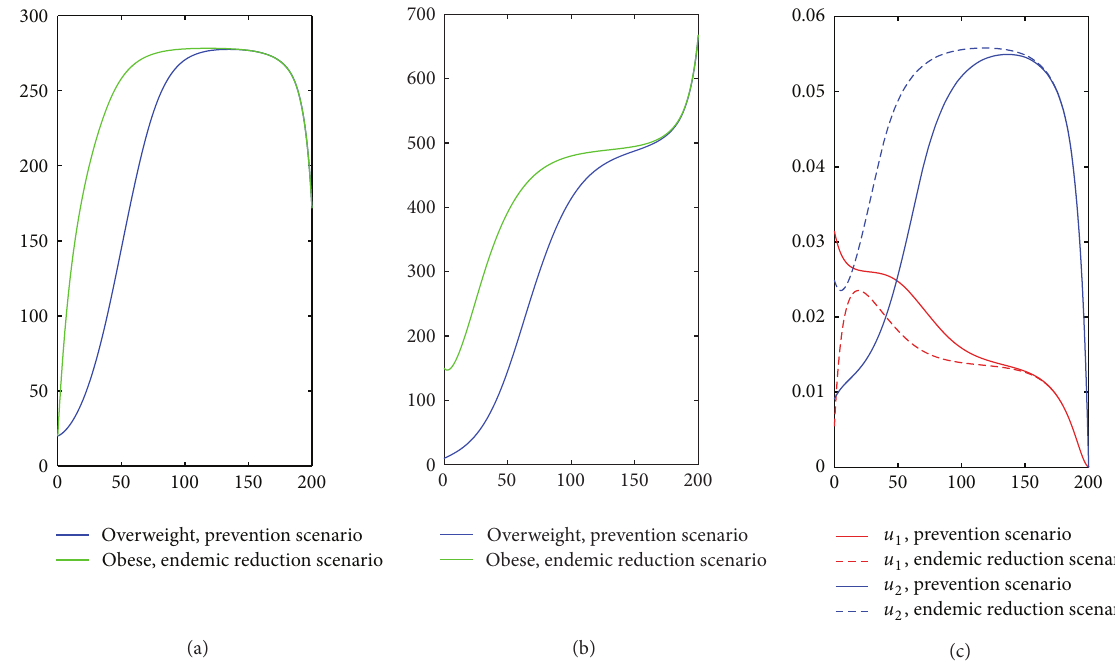
Figure4:Numericalsimulationsofoverweight(a)andobese(b)compartmentsandcontrolvariable(c)forpreventionandendemicreduction scenario.